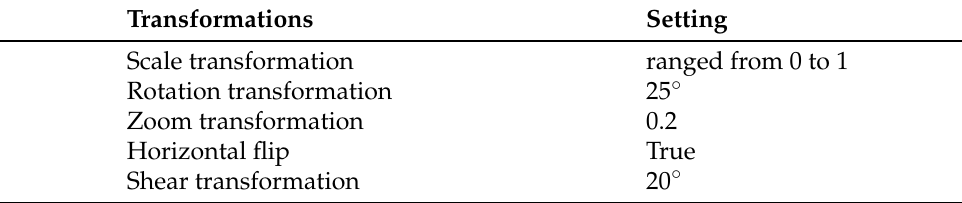
Table 3. Image augmentation techniques.